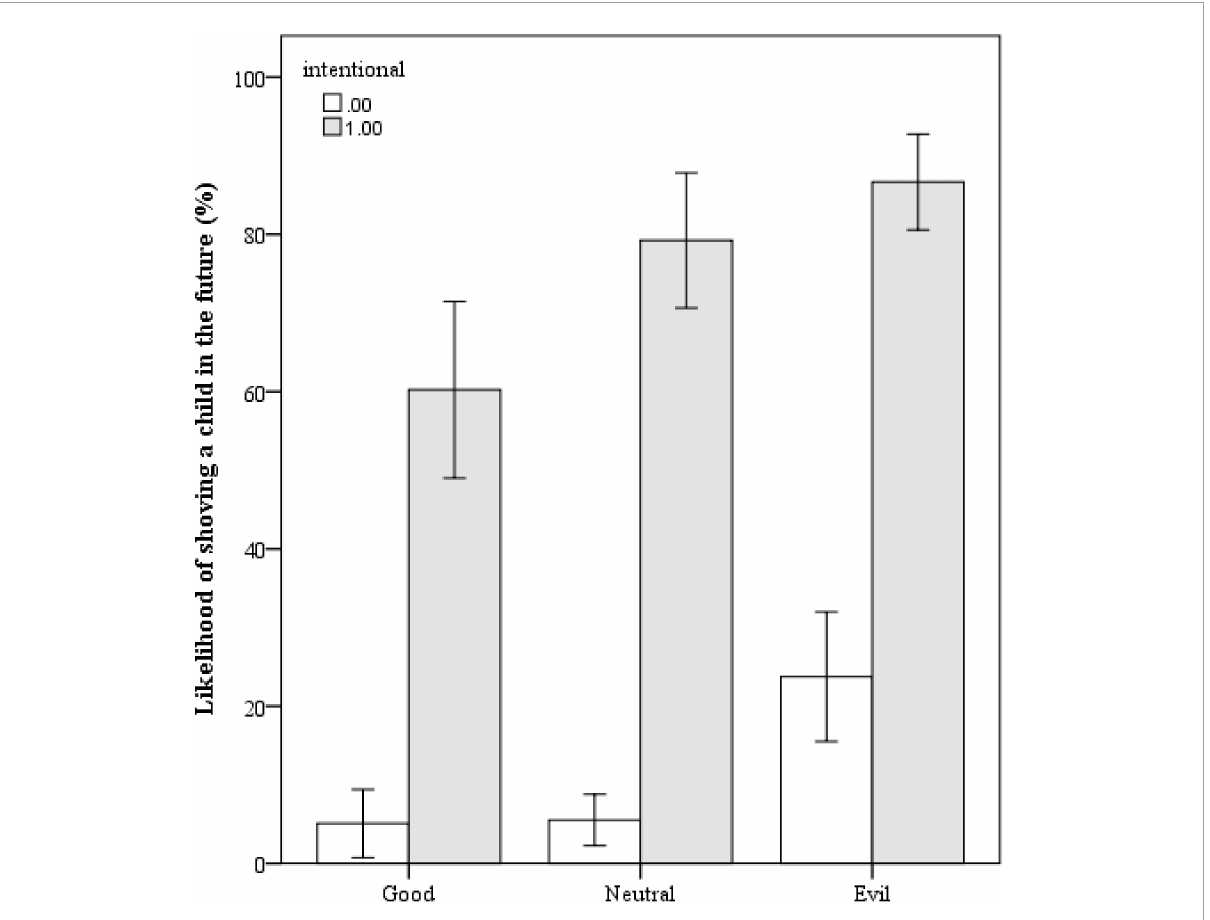
FIGURE5 Likelihood of shoving a child who runs into someone again in the future. Error bars are 95% confidence